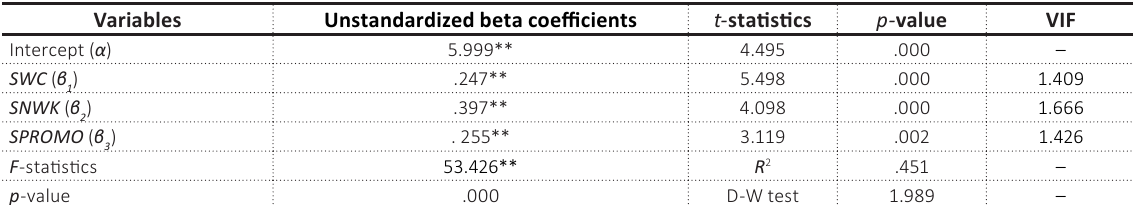
Table 3. Multiple regression equation of AC on all predictor